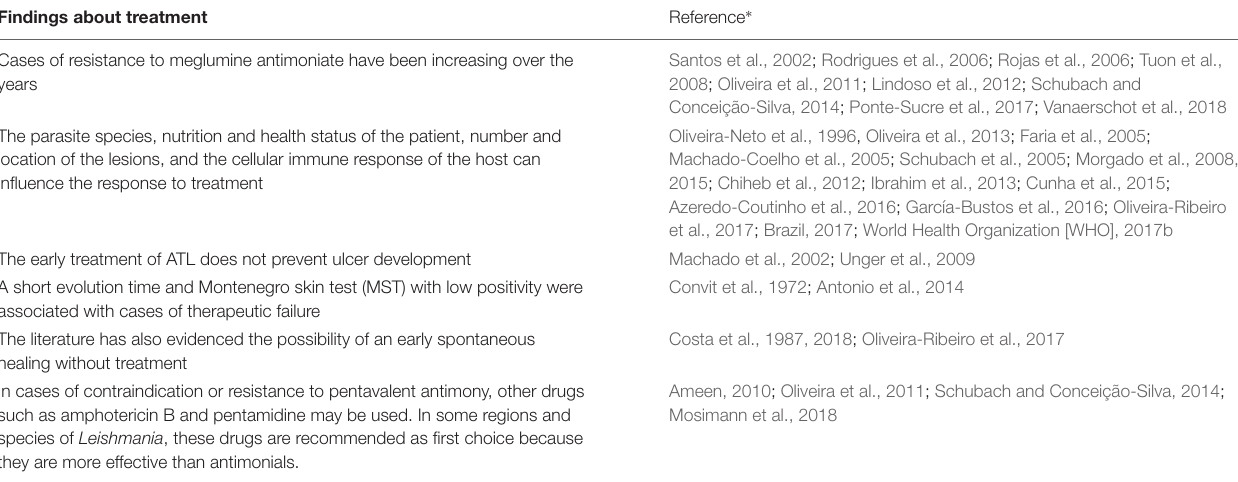
TABLE 2 | Summary of the aspects involved in human TL treatment. Findings about